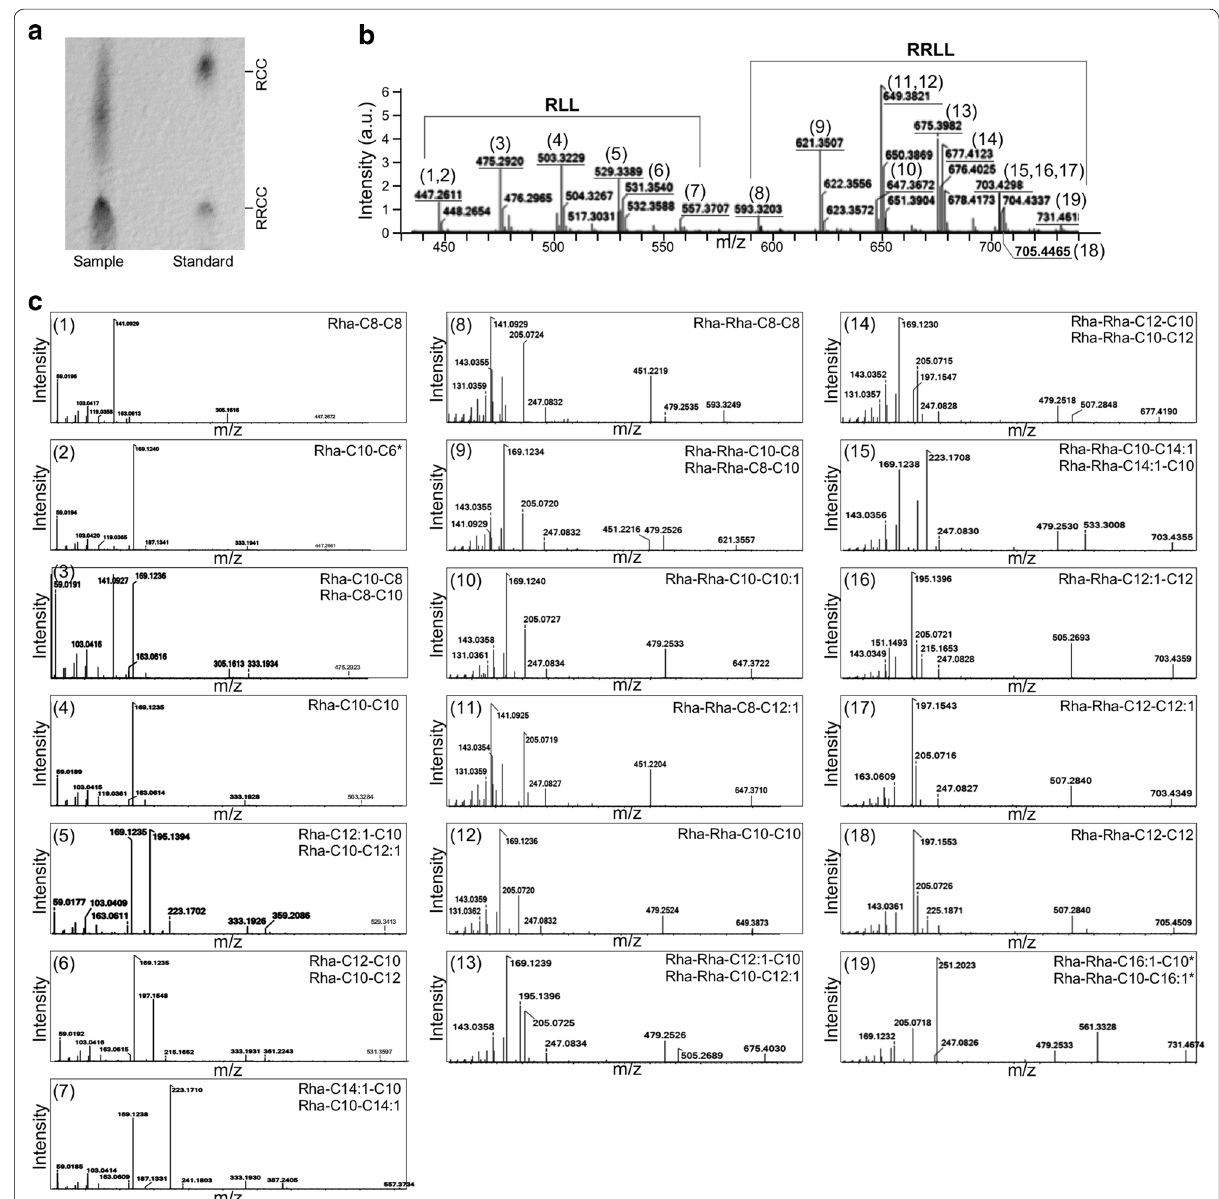
Fig. 3 Identification of various types of rhamnolipids produced by P. aeruginosa ZS1. a Thin layer chromatographic analysis of the rhamnolipids pro- duced by P. aeruginosa ZS1. Sample and standard molecules are indicated. Positions of the reference molecules Rha-C10-C10 and Rha-Rha-C10-C10 are indicated. b MS spectra of the rhamnolipids produced by P. aeruginosa ZS1. X - and Y -axis indicate m/z (mass-to-charge ratio) and intensity (arbitrary unit), respectively. Number in parentheses indicates various types of rhamnolipids detected in supernatant of P. aeruginosa ZS1. c MS–MS spectra of the individual peaks shown in MS spectra ( b ). Display is identical to b . Top right and left indicate the number of peaks shown in b and formulas of rhamnolipids. Asterisk indicates the rare type of rhamnolipids whose spectra was not reported